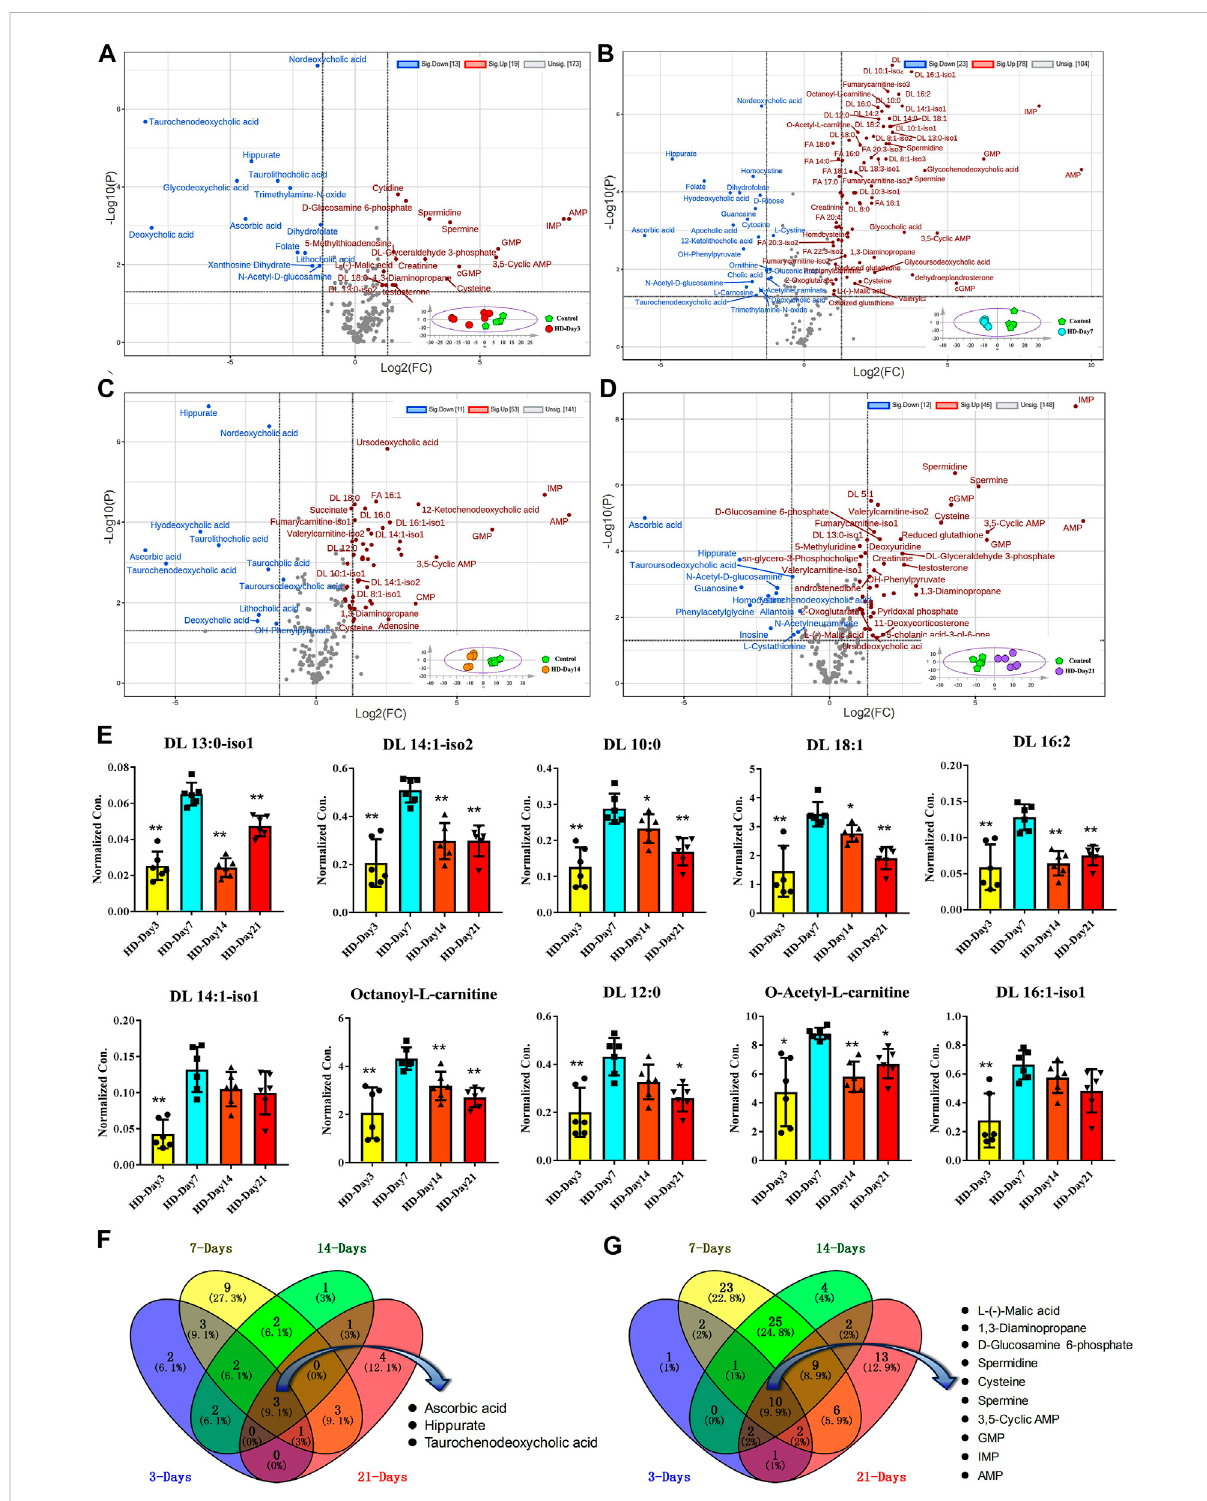
FIGURE 5 (A – D) Volcano plots based on the targeted metabolomics data of control group and HD group in the 3-day, 7-day, 14-day and 21-day dosing durations, respectively. (E) Time-dependent manners of the top 10 fatty acyl carnitines with the most signi fi cant changes among different moxi fl oxacin dosing durations. Statistical differences between the other HD groups ad the 7-day HD group were examined using t-tests. *, p < 0.05; **, p < 0.01. (F,G) Venn plots showing the overlap of the signi fi cantly decreased and increased metabolites in HD group of different dosing durations,